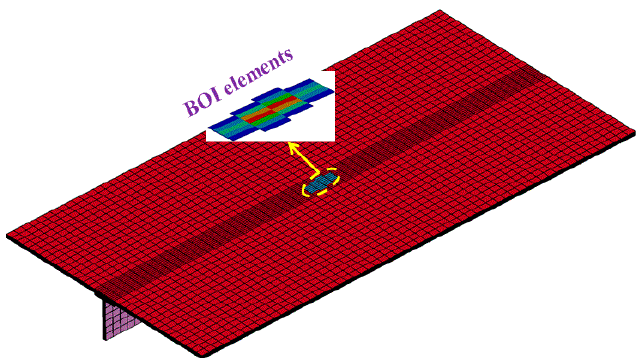
Figure 9. Finite element model of the blow-off impulse of the composite reinforced panel.